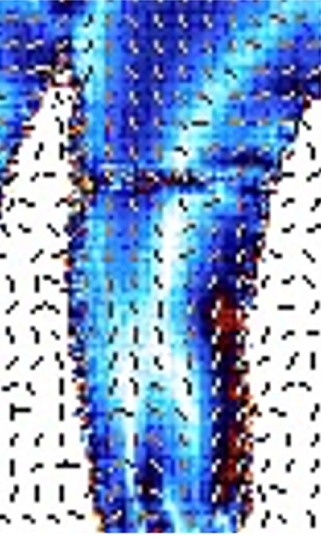
Figure 4. Stress direction analyzing image indicating the stress direction as vertical to each dash. The blue area shows photoelastic resin and white area shows tooth root.